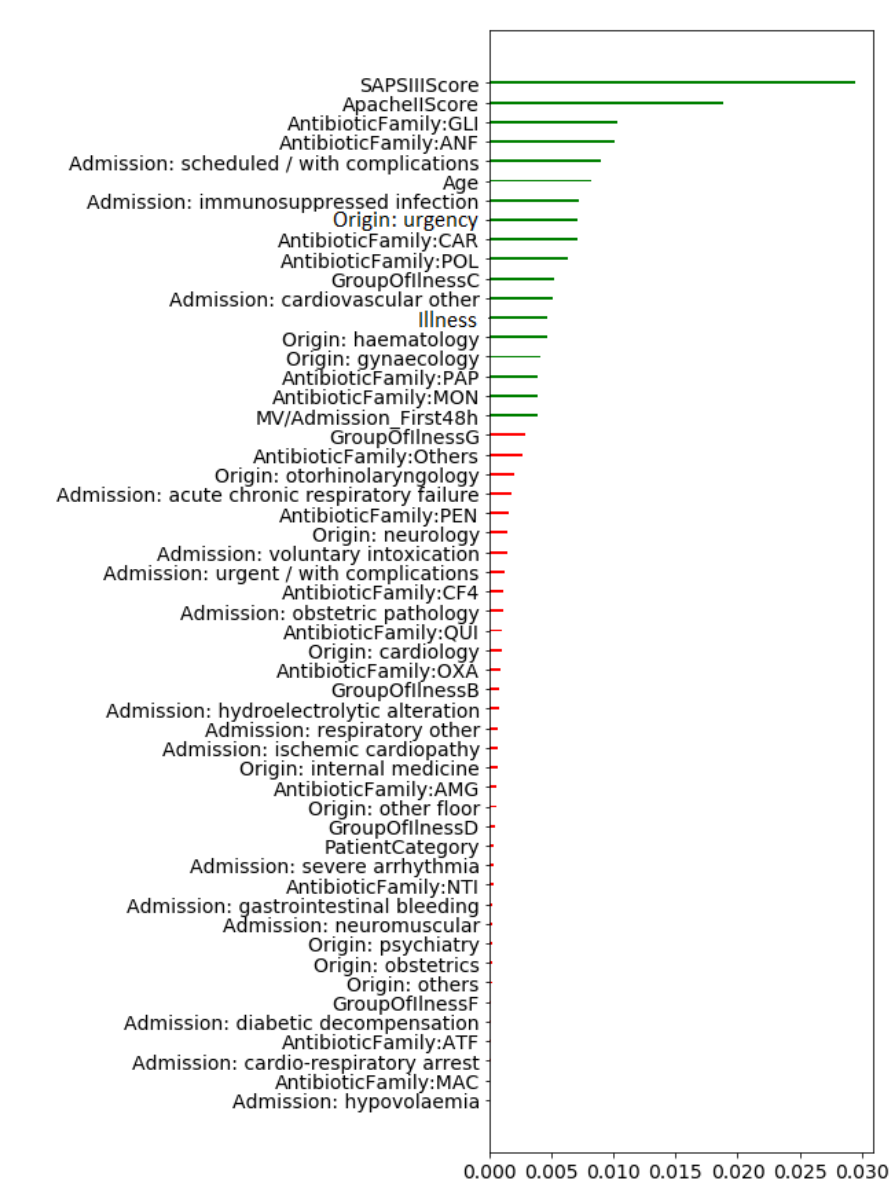
Figure 10. Averaged mutual information (MI) values when bootstrapping the patient episodes for each feature. Features with very low MI values are not shown here. In green, the 18 features with higher MI